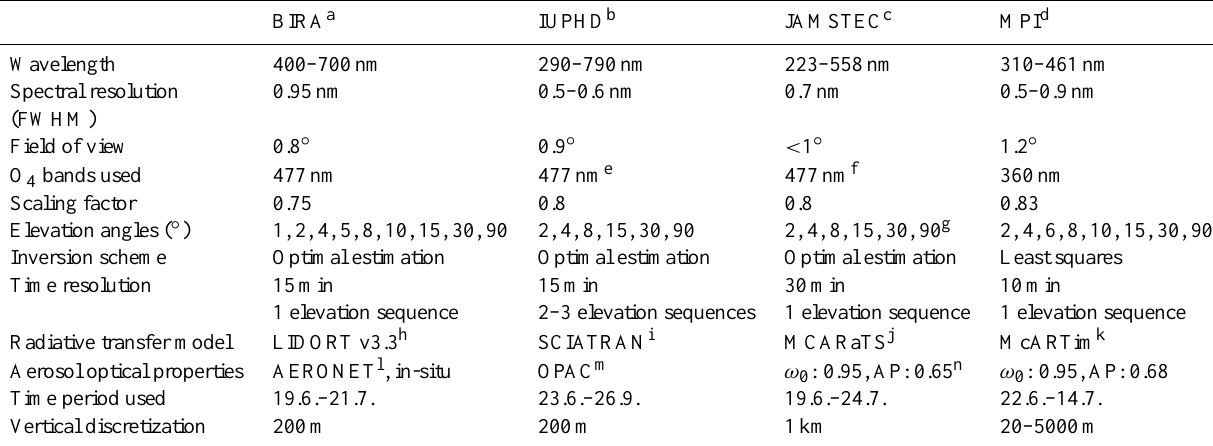
Table 1. Overview of the main MAX-DOAS technical and inversion